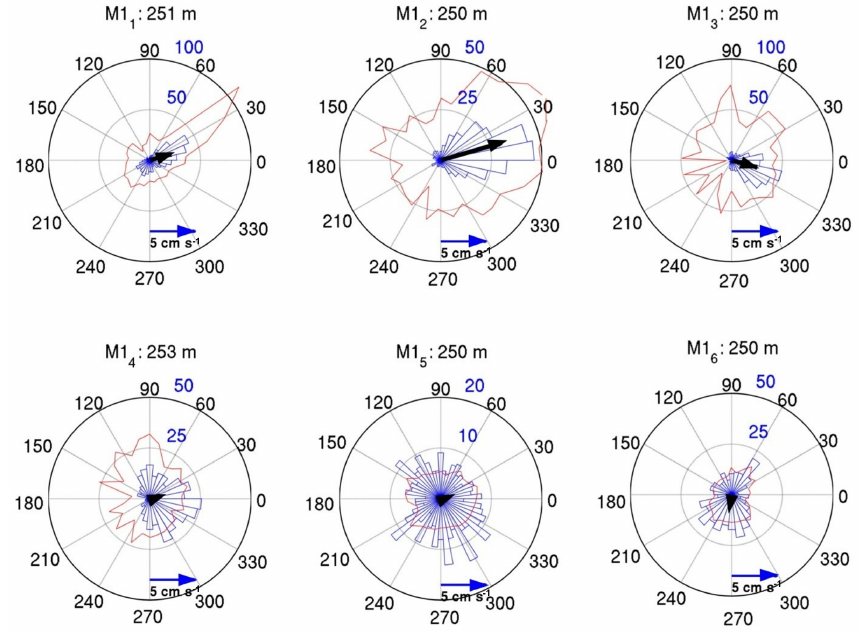
Figure 7. Current directions and speed at ∼ 250m (in proximity to AW temperature core) at six moorings at the Laptev Sea slope in 2013– 2015. Blue sectors show the distribution of current directions (persistence of direction is given in days; gray circles). Red lines indicate the mean current speed within 12 ◦ directional bins. The black arrows represent the record-long mean currents. The same linear scale is used to show the mean current speed within directional bins and the mean current